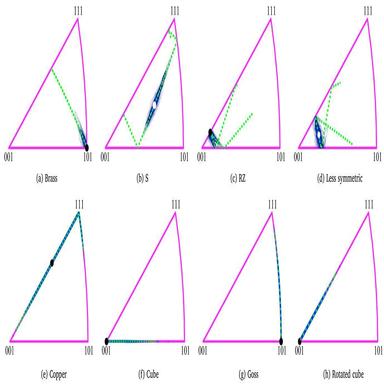
Inverse Pole Figures (IPFs) of variant H1 of the honeycomb structures at 33 = 0.03 . Top row shows contour plots and bottom shows discrete plots. The circle denotes the original orientation. Figure adopted from with permission from Elsevier.